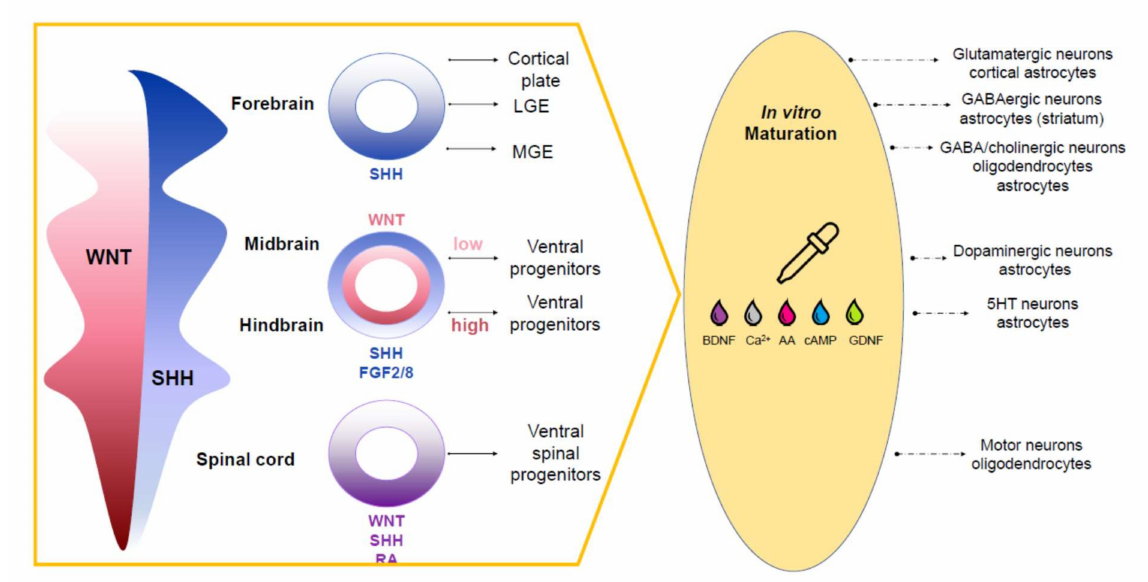
Figure 2. The gradient of morphogens, growth factors, and neurotrophic factors define the differentiation into a particular type of brain cells. Initially, the concentration of morphogens WNT and SHH is crucial. For example, the high concentration of SHH accompanied with a low level of WNT allows obtaining the forebrain structures. At the same time, the ventral distribution of the SHH concentration is also important—a high level allows the development of MGE zones; a low level allows for the cortical plate. High WNT at low SHH promotes the development of the spinal cord, and its dorsal gradient at low values, coupled with a high concentration of FGF2/FGF8, gives the development of ventral progenitors of the hindbrain, and in combination with an increase in the level of WNT, ventral progenitors of the midbrain develop. It is characteristic that for most types of neurons in all parts of the brain; the presence of neurotrophic factors, such as BDNF/GDNF, calcium ions, cAMP, and other factors, is necessary for maturation and